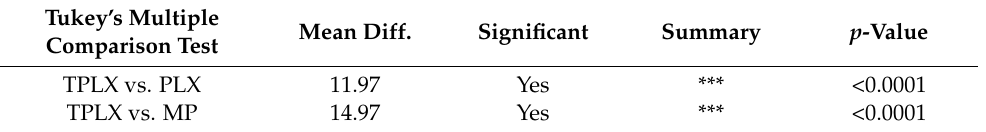
Table 9. The output of the statistical